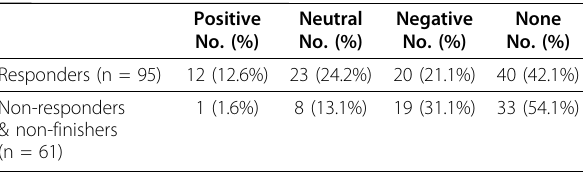
Table 1 Response to hypnotherapy and mood